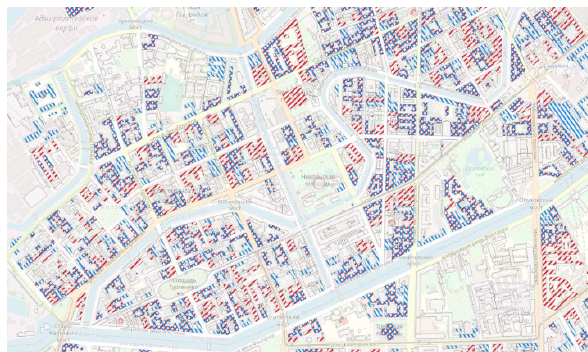
Figure 7. Joint mapping of HIV (red hatching) and tuberculosis (blue hatching) cases reported in 2019 in Admiralteysky district of St. Petersburg (base map © OpenStreetMap contributors)